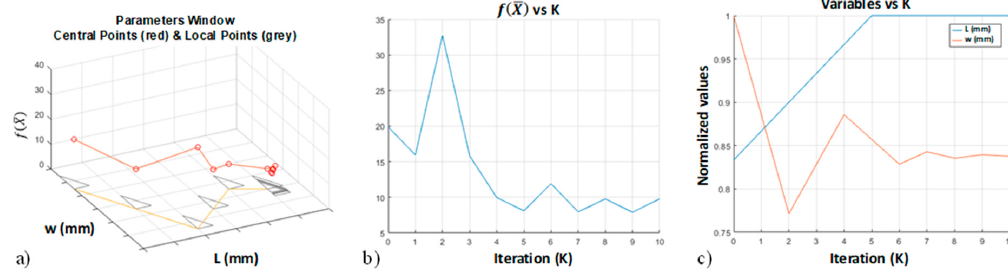
Figure 6. Example of the steps of the optimization algorithm (Large-Tee). In particular, ( a ) 3D (cid:16) (cid:17) representation of 𝑓(cid:4666)𝑋(cid:3364)(cid:4667) in (L, w) domain; ( b ) values of L and w variables and ( c ) values of 𝑓(cid:4666)𝑋(cid:3364)(cid:4667) X representation of f in (L, w) domain; ( b ) values of L and w variables and ( c ) values of f during the algorithm iteration. the algorithm iteration.